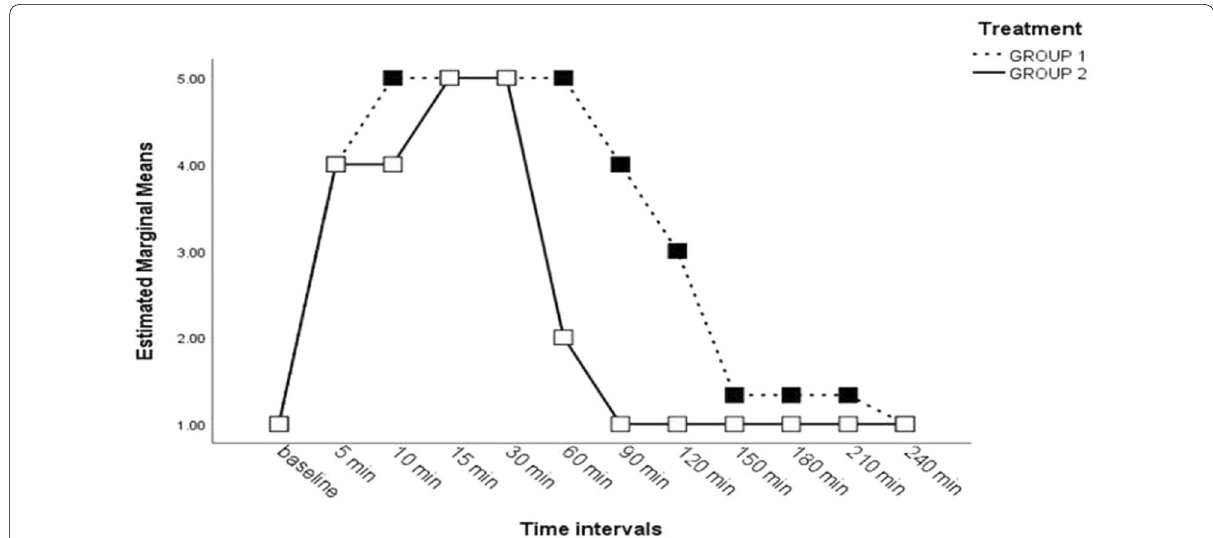
Fig. 4 Line chart shows the means of the sedation score for the two groups at different time